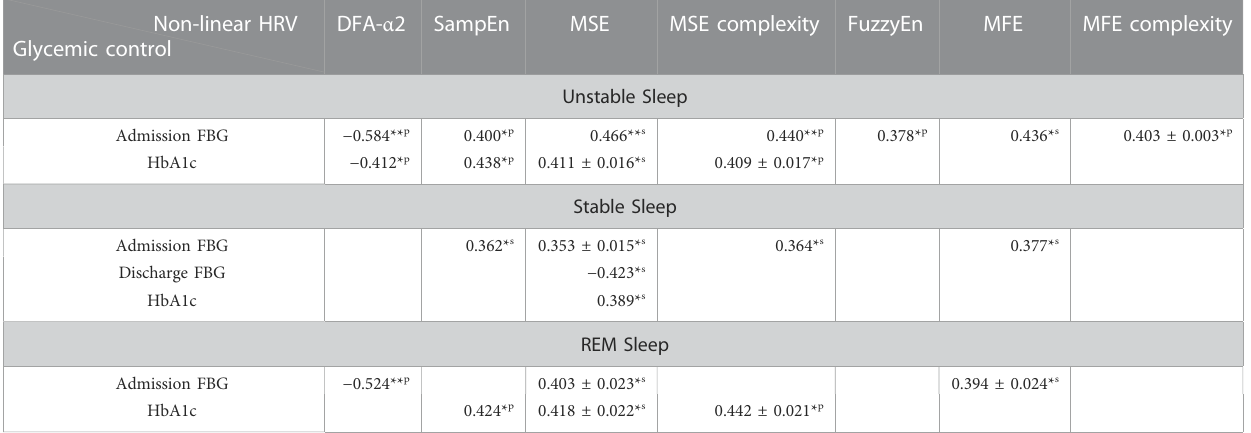
TABLE7Correlationcoef fi cients between non-linear HRV metricsinthreesleepstages andclinicalglycemic controlindicatorsincludingadmissionFBG,discharge FBG and HbA1c.